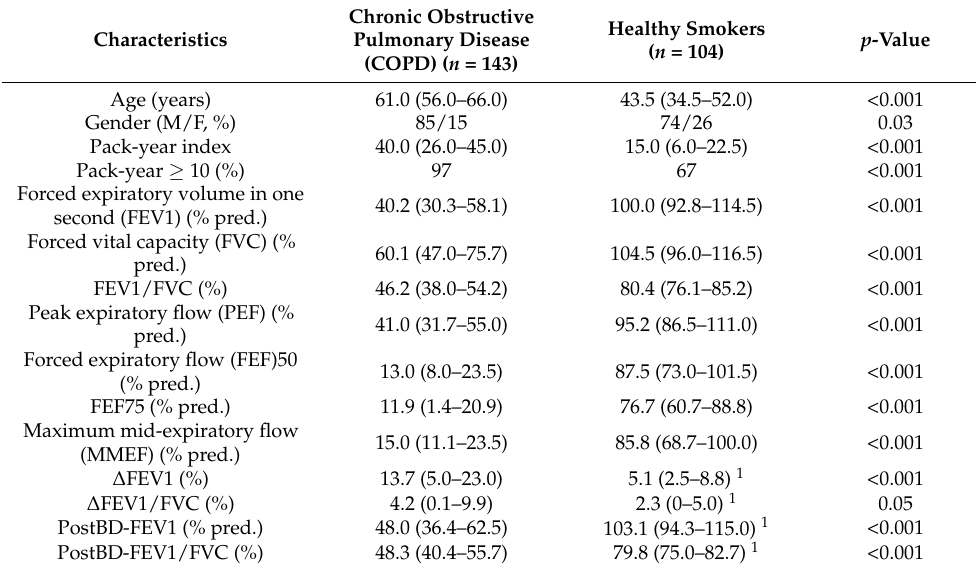
Table 2. Clinical and Functional Characteristics of the Studied Groups.